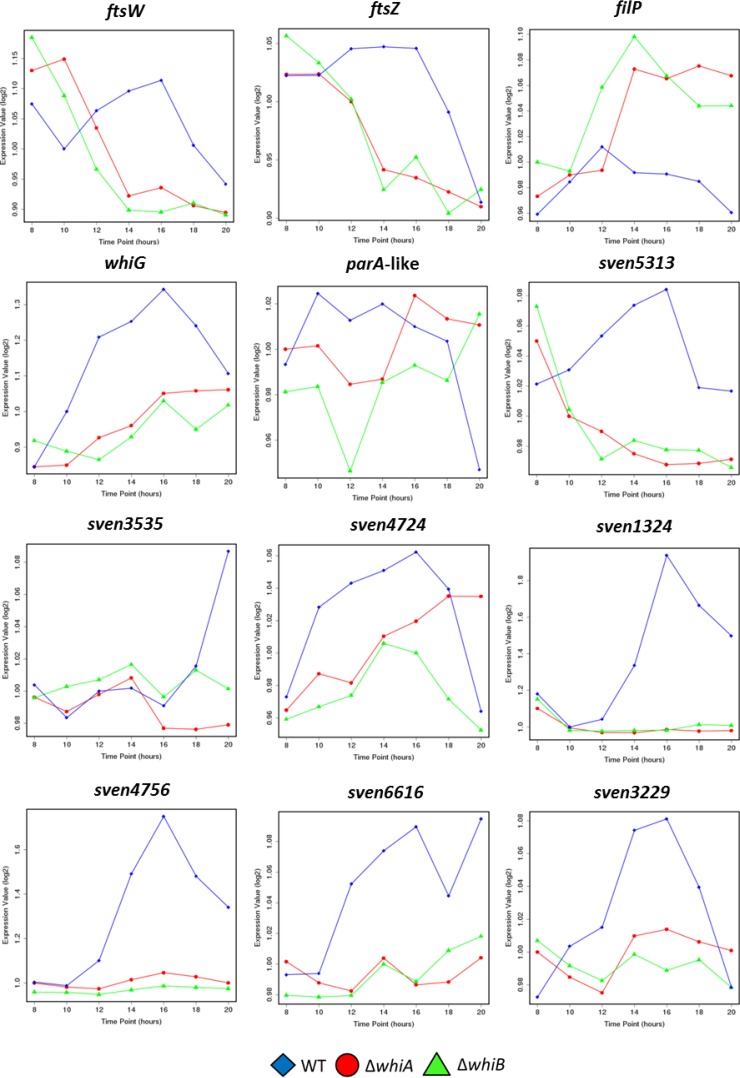
WhiA and WhiB targets depend on both whiA and whiB for their expression. Data represent results of microarray transcriptional profiling for 12 selected WhiA and WhiB target genes (ftsW, ftsZ, filP, whiG, sven1406, sven5313, sven3535, sven4724, sven1324, sven4756, sven6616, and sven3229) during submerged sporulation in wild-type S. venezuelae (blue diamonds); the congenic whiA mutant, SV11 (red circles); and the congenic whiB mutant, SV7 (green triangles). In each panel, the x axis indicates the age of the culture in hours, and the y axis indicates the per-gene normalized transcript abundance (log2). For the wild type, 10 to 14 h corresponds to vegetative growth, 14 to 16 h corresponds to the onset of sporulation (fragmentation), and 16 h and beyond corresponds to sporulation. The arrangement of the 12 panels mirrors that in Fig. 3.